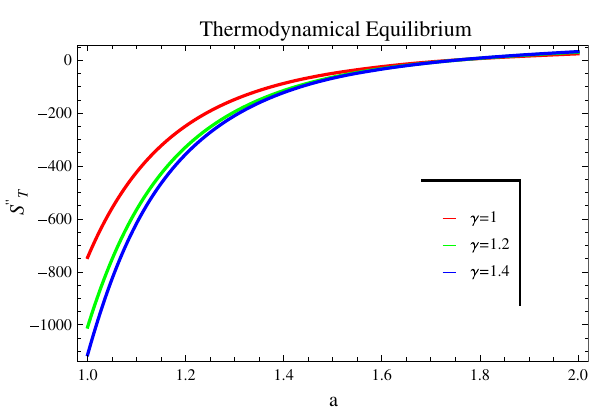
Fig. 5 Plot of S (cid:7)(cid:7) versus a for logarithmic corrected entropy using T k = 1 , λ = − 1 , α = − 1 , L p = 1 , β = 1 and b = 1